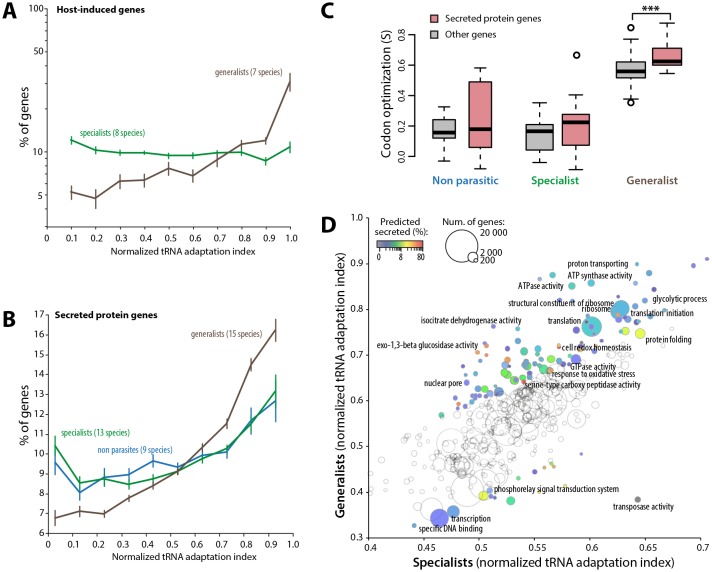
Codon optimization strongly associates with host colonization in generalist fungal parasites.(A) Genes induced during host infection are enriched among high tRNA adaptation index genes in generalist but not specialist parasite genomes. Error bars show standard error of the mean. (B) Genes encoding predicted secreted proteins are more strongly enriched among high tRNA adaptation index genes in generalist parasite genomes compared to specialist and non-parasitic fungi genomes. Error bars show standard error of the mean. (C) Degree of coadaptation of secreted protein genes and other genes to the genomic tRNA pool in non parasitic, specialist and generalist fungi (*** Student’s paired t-test p<0.002). (D) Distribution of tRNA adaptation indices according to gene functions in generalist and specialist fungal parasites. For each Gene Ontology (GO), the average normalized tRNA adaptation indices in all genes from generalist and specialist genomes are shown. Bubbles are sized according to the total number of genes, and colored according to the percentage of predicted secreted proteins when values for generalists and specialists differ by over 10%. Selected GOs are labeled.DOI:
http://dx.doi.org/10.7554/eLife.22472.01710.7554/eLife.22472.018Figure 5—source data 1.Summary of gene expression data used for the analysis of tAI in host-induced genes.DOI:
http://dx.doi.org/10.7554/eLife.22472.01810.7554/eLife.22472.019Figure 5—source data 2.Distribution of host-induced genes according to tAI (as % of all host-induced genes).DOI:
http://dx.doi.org/10.7554/eLife.22472.01910.7554/eLife.22472.020Figure 5—source data 3.Distribution of secreted protein genes according to tAI (as % of all host-induced genes).DOI:
http://dx.doi.org/10.7554/eLife.22472.02010.7554/eLife.22472.021Figure 5—source data 4.Codon optimization values in secreted and non-secreted proteins for each of the 45 fungal genomes analyzed in this work.Cat. Category; NP, non parasitic; Gen, generalist; Spe, specialist; No. Sec. Prot., Number of secreted proteins.DOI:
http://dx.doi.org/10.7554/eLife.22472.02110.7554/eLife.22472.022Figure 5—source data 5.Distribution of tRNA adaptation indices per Gene Ontology in generalist and specialist genomes.